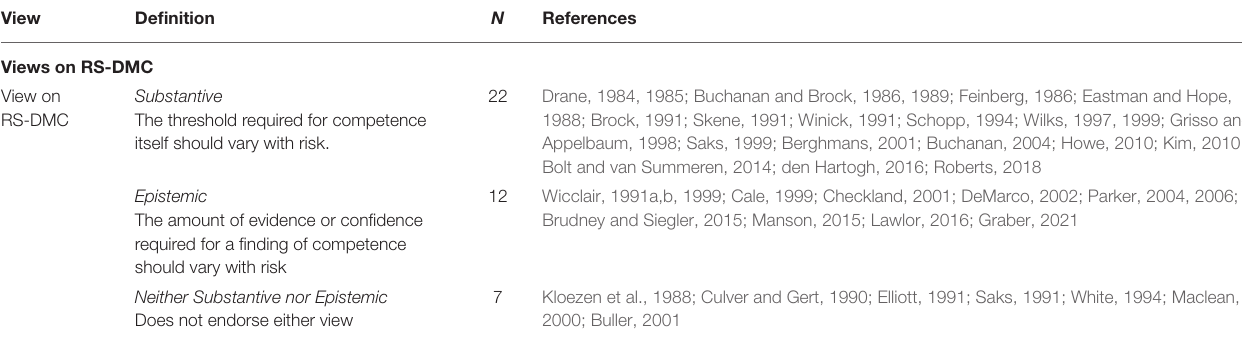
TABLE 1 | Views on